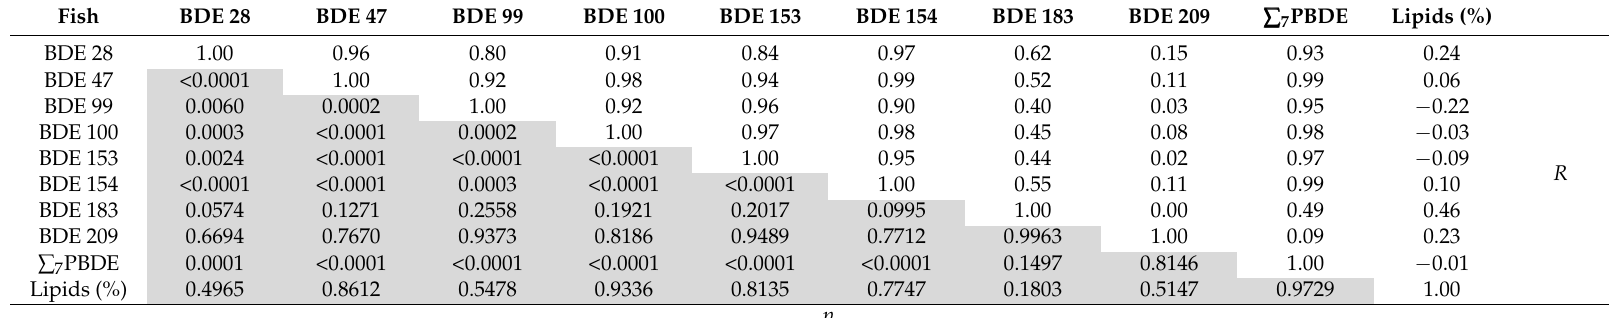
Table 5. Pearson correlation coefficients and p -values calculated for PBDE concentrations and the content of lipids analyzed in tissues of European perch ( Perca fluviatilis ). Fish